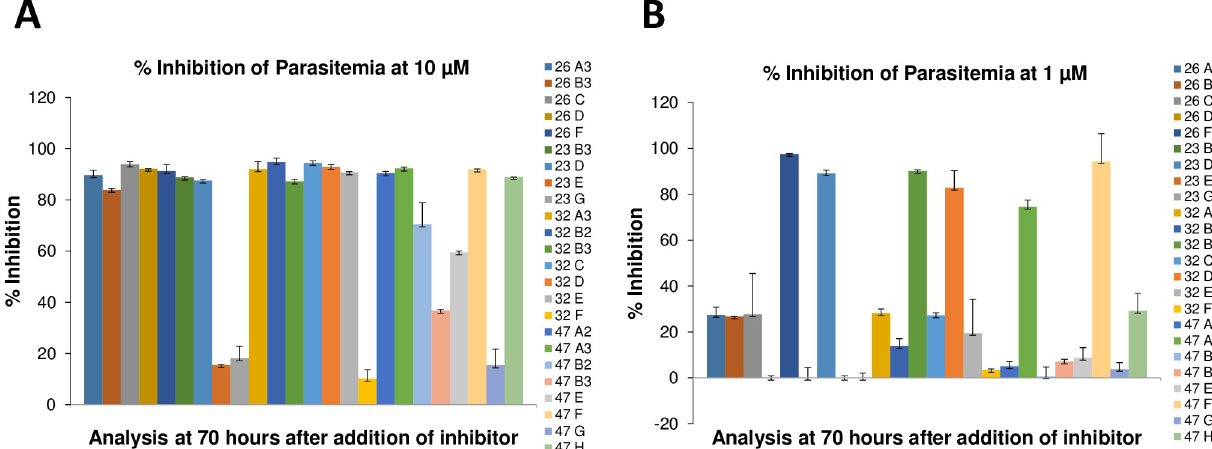
Fig 2. Percent inhibition of malaria parasitemia in RBCs following treatment with the most potent Eli Lilly compounds administered at 10 μ M (panel A) and 1 μ M (panel B) concentrations. The indicated per cent inhibition was determined at the 22 hours post invasion time point in the parasite’s second life cycle (at the 70 hour time point in Fig 1), when control cultures were at the mature ring stage of development. All the treatments were done in duplicate.